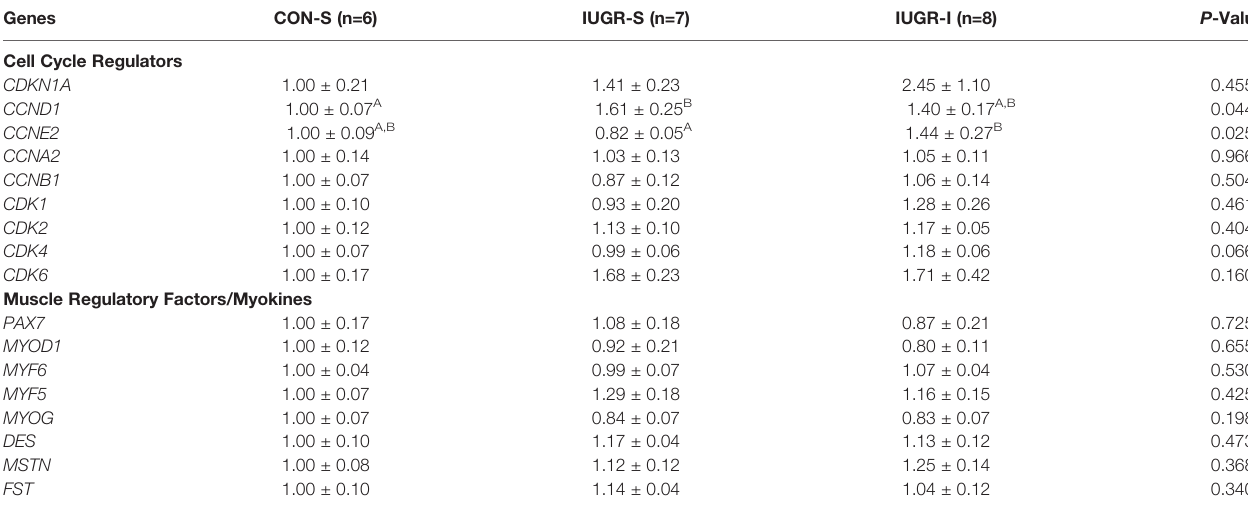
TABLE 4 | Skeletal muscle, biceps femoris, mRNA expression (fold change from CON-S). Genes CON-S (n=6) IUGR-S (n=7) IUGR-I (n=8) P